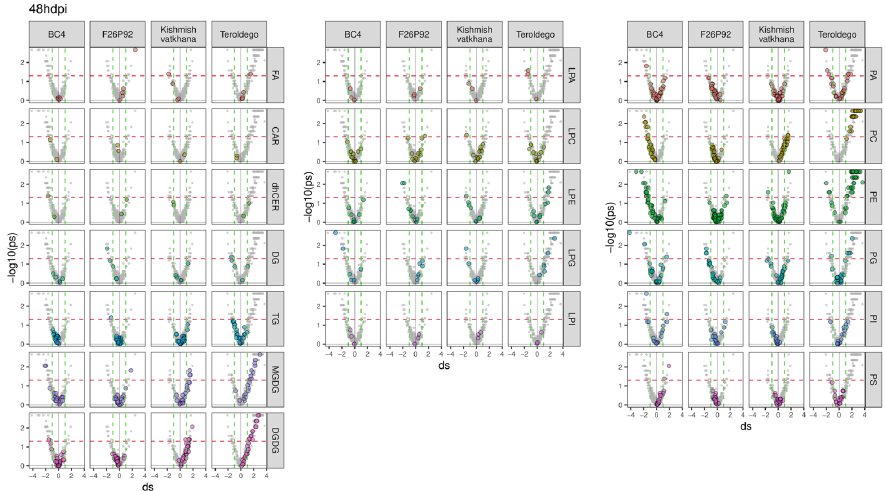
Figure 3. Lipids with values above the discontinued red line were significantly modulated, with up- accumulated lipids shown on the right and down-accumulated lipids shown on the left of the volcano plot for all four genotypes at 48 hpi over the course of the two years of data analysis (2019–2021). The left graph shows the modulation of glycerolipids, sphingolipids, and fatty acids, whereas the middle and right graphs show the modulation of glycerophospholipids. The colors reflect the various lipid classes, while “ds” represents the calculated Cohen’s d values.